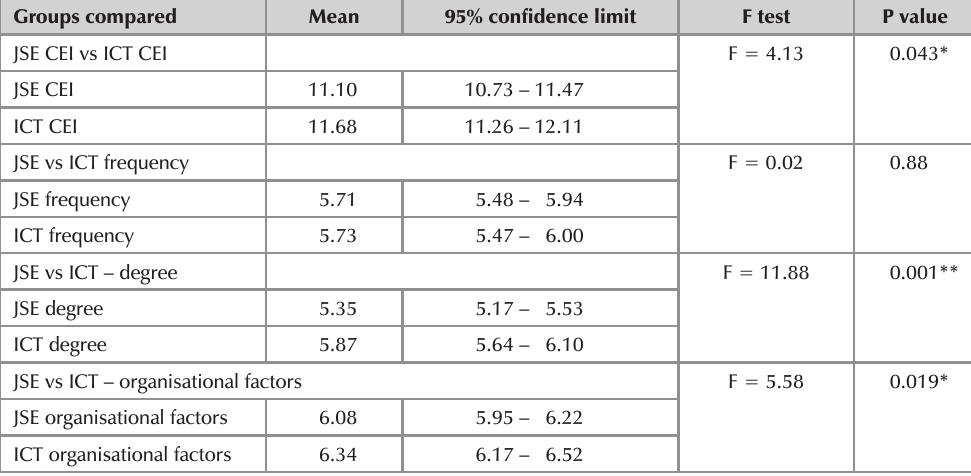
Groups compared: CEI and organisational